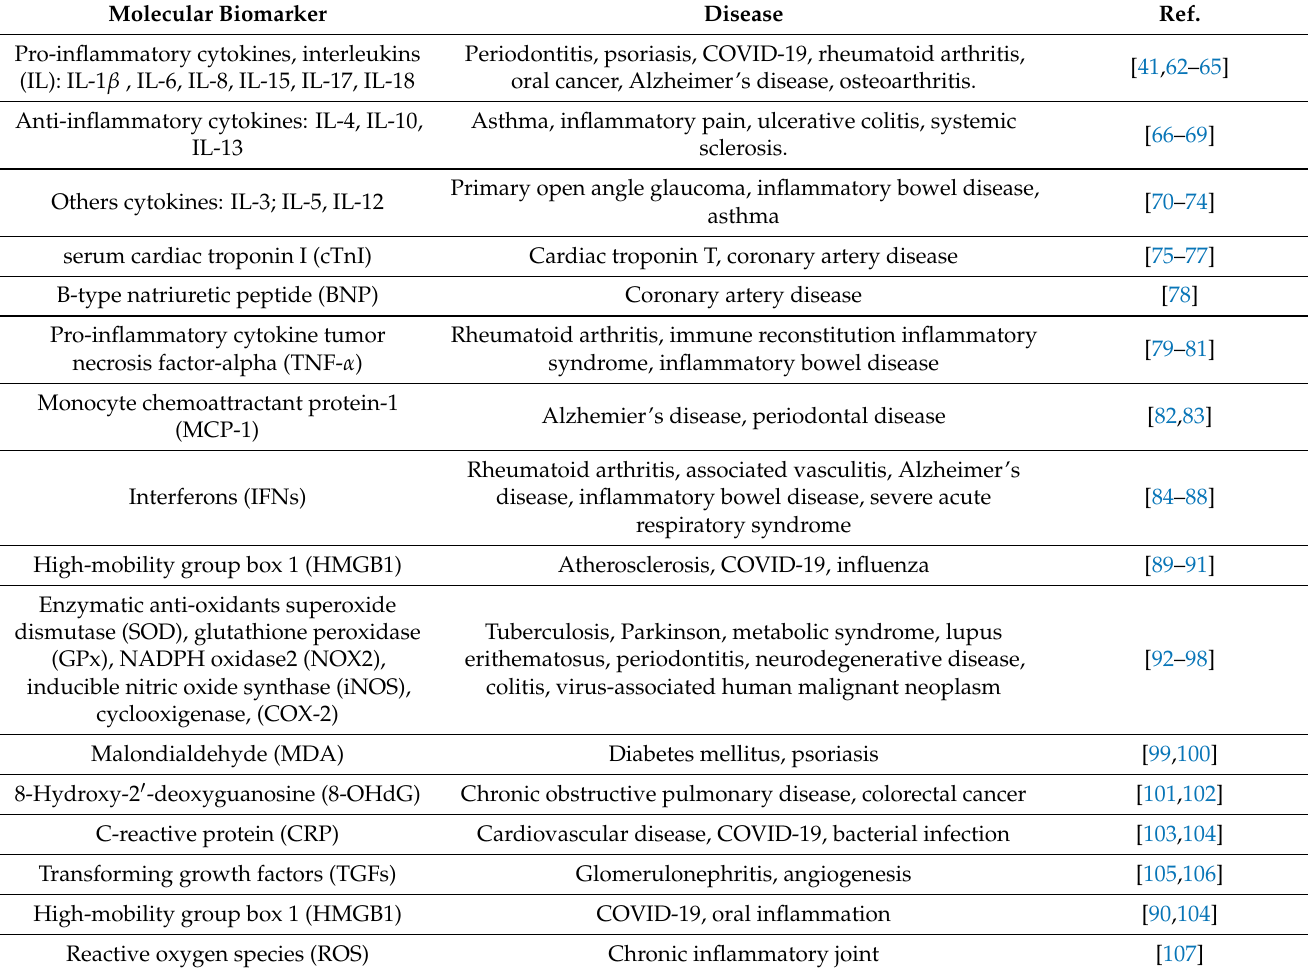
Table 1. Main molecules that constitute the chronic inflammatory disease as potential